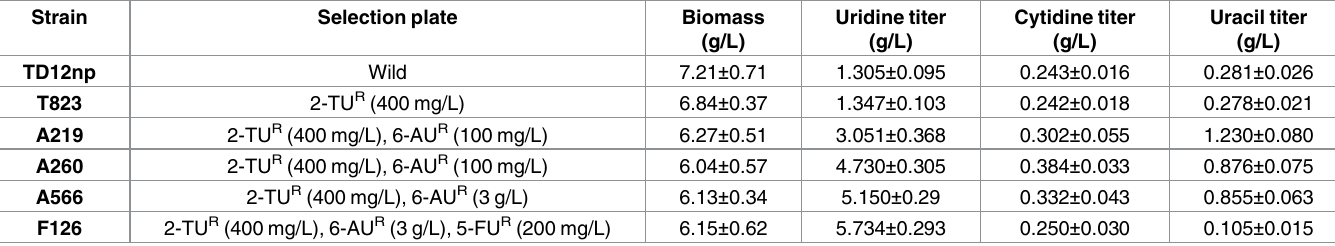
2-TU R represents 2-thiouracil resistance; 6-AU R represents 6-azauracil resistance; 5-FU R represents 5-fluorouracil